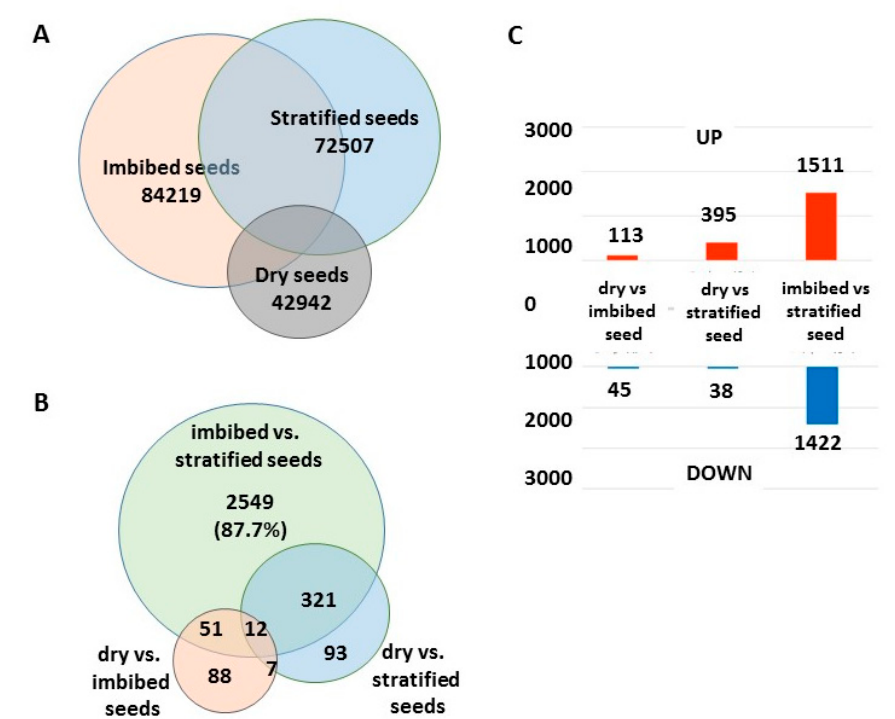
Figure 5. Comparison between the total transcript distribution and the common differentially expressed genes (DEGs) in dry, imbibed, and stratified seeds of A. sativum. ( A ) Total number of expressed genes in the three seed samples. ( B ) Distribution of 2933 differentially expressed genes in three comparisons between samples. ( C ) Upregulation and downregulation of gene expression in the comparisons between the three seed samples.